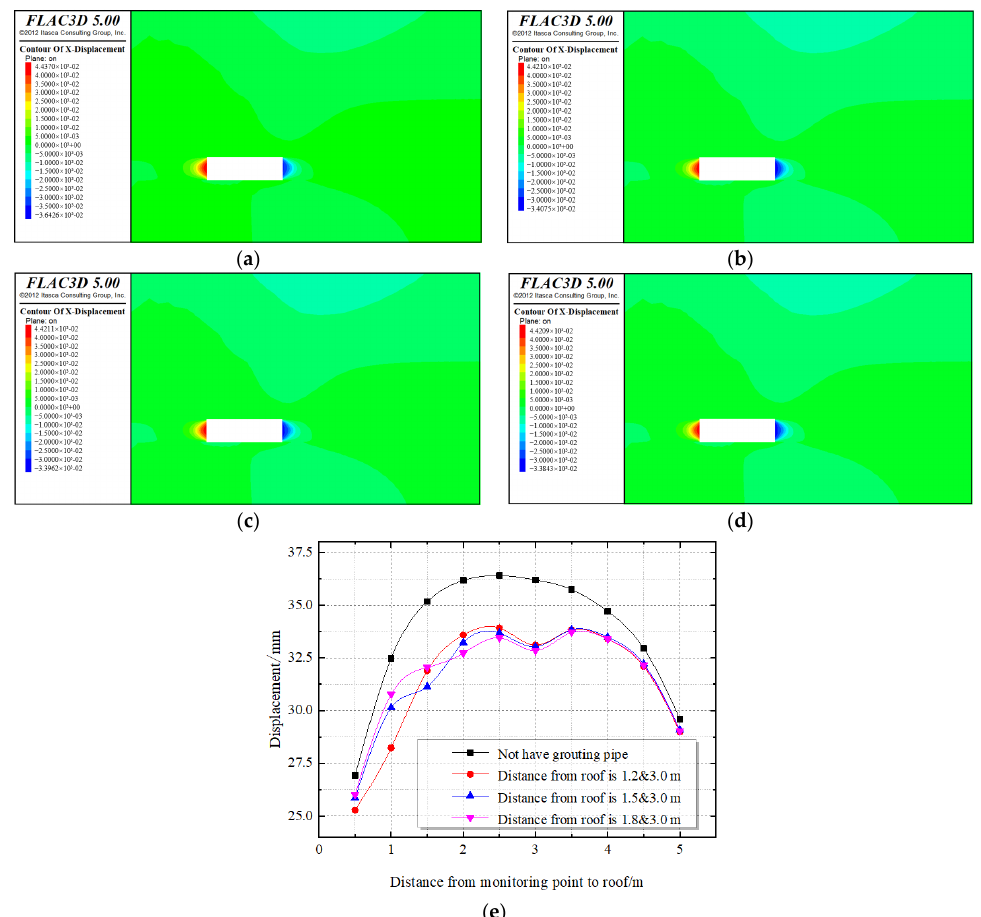
Figure 17. Horizontal displacement of monitoring points with different distances between double- row grouting holes and roof: ( a ) no grouting pipe; ( b ) grouting pipe is 1.2 and 3 m away from the roof; ( c ) grouting pipe is 1.5 and 3 m away from the roof; ( d ) grouting pipe is 1.8 and 3 m away from the roof; ( e ) displacement line chart.